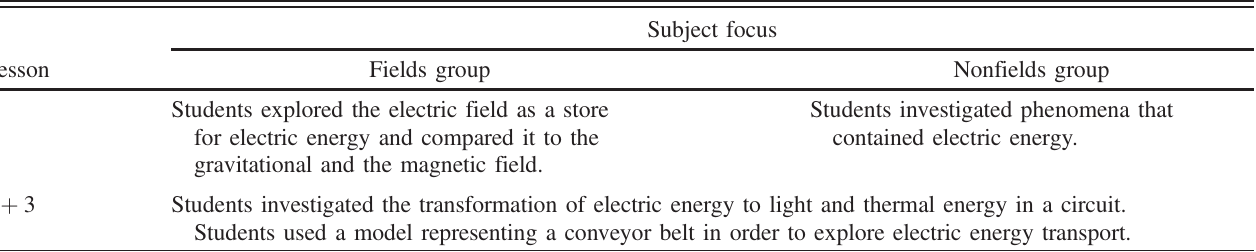
TABLE I. Overview of lesson contents during the units for both groups.